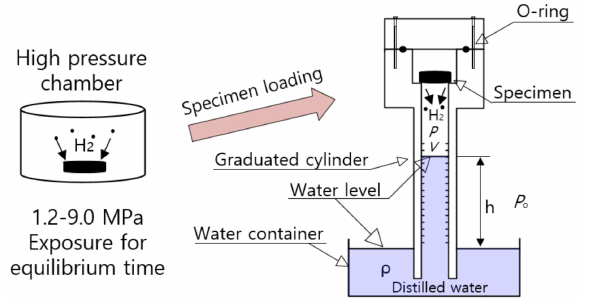
Figure 1. Configuration of the volumetric analysis system using a graduated cylinder after high- pressure exposure for 24 h and subsequent